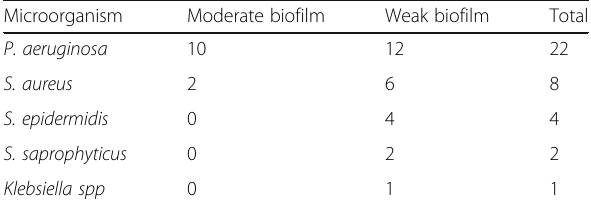
Table 2 Distribution of biofilm forming isolates